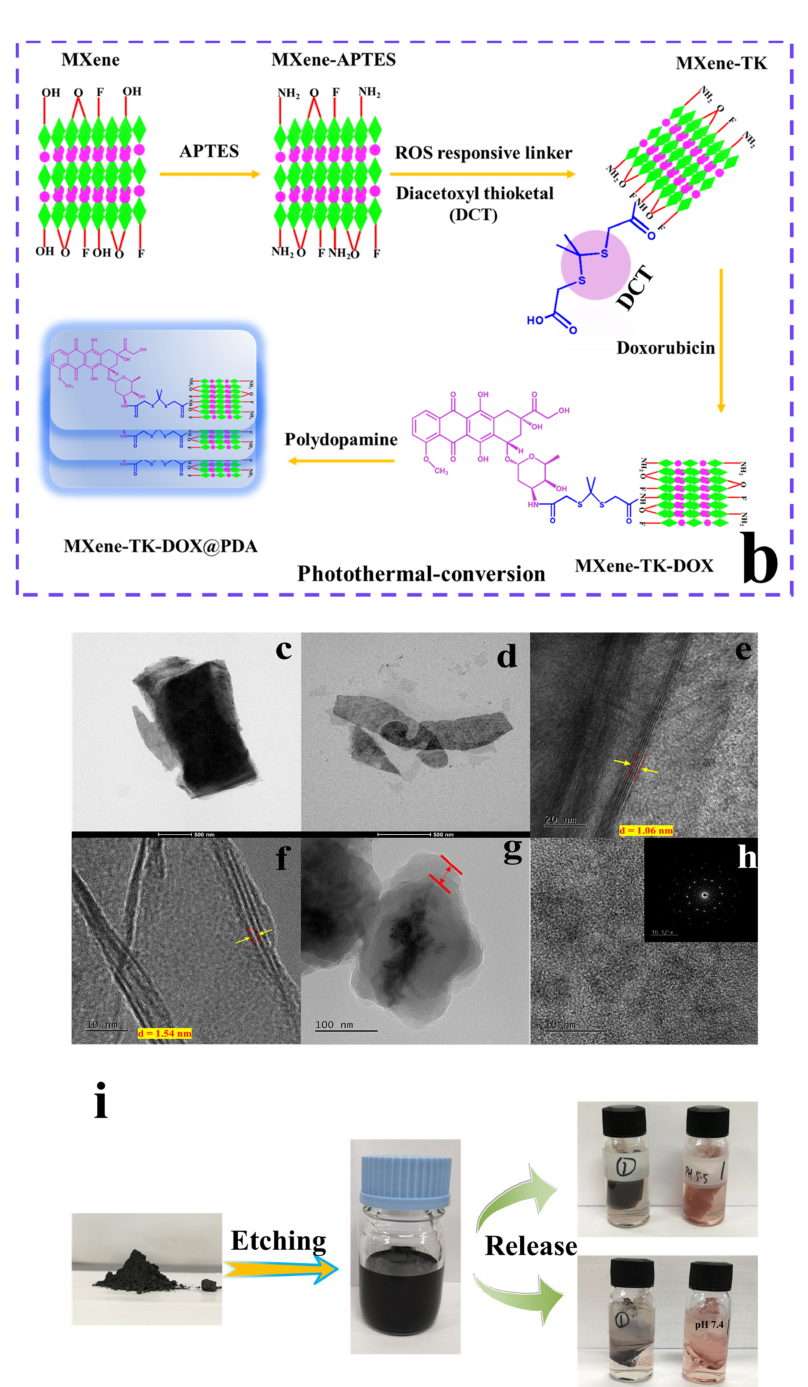
Figure 1. ( a ) Schematic representation of the MXene synthetic process including etching, interca- lation, and centrifugation. ( b ) Illustration of the preparation process of MXene − TK − DOX@PDA nanoparticles by reaction with APTES, thioketal, doxorubicin, and coating with PDA, respectively. ( c , d ) TEM images of the pristine MXene nanosheets before and after delamination by TBAOH. ( e ) High resolution TEM image of the MXene nanosheets after HF etching (d = 1.06 nm). ( f ) High resolution TEM image of the MXene + TBAOH nanoparticles (d = 1.54 nm). ( g ) TEM image of the MXene − TK − DOX@PDA nanoparticles. ( h ) HRTEM image of MXene and selected area electron diffraction (SAED) (inset). ( i ) Illustration of the process of MXene synthesis and the doxorubicin release from MXene − TK − DOX@PDA